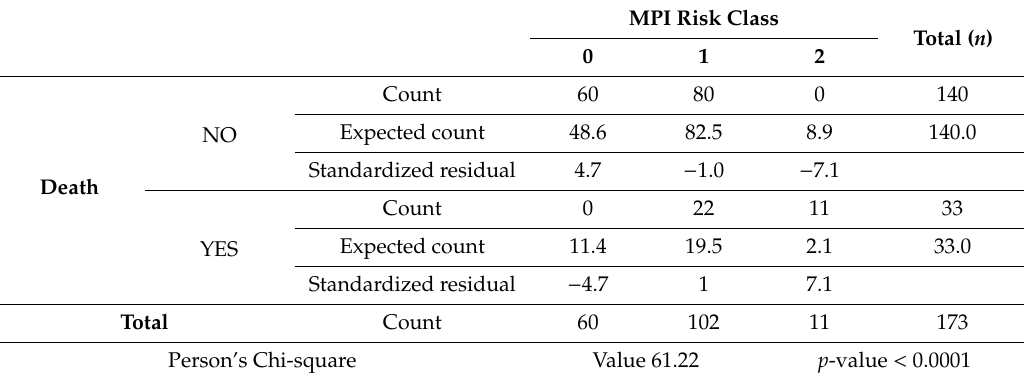
Table 3. Association between mortality (death no / yes) and multidimensional prognostic index (MPI) by risk classes. (Risk class 0 = MPI between 0 and 0.33; Risk class 1 = MPI between 0.34 and 0.66; Risk class 2 = MPI between 0.67 and